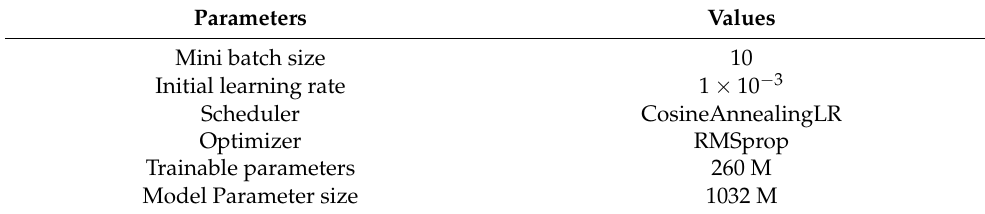
Table 1. Model complexity and